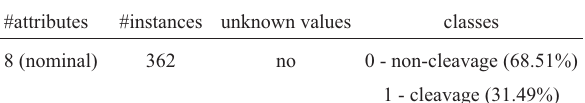
Table 2 - Data set description.